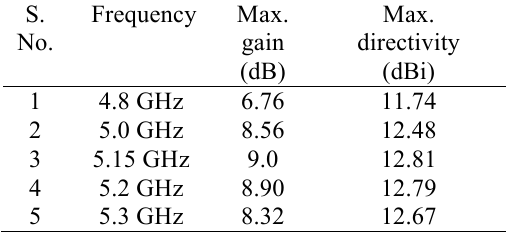
Figure 10: Radiation patterns of the array (a) in 3D at 5.15 GHz, (b) in ∅ = 0 ! plane at 5 GHz and 5.15 GHz, (c) in ∅ = 0 ! plane at 5.25 GHz and 5.35 GHz, (d) in ∅ = 90 ! plane at 5 GHz and 5.15 GHz, (e) in ∅ = 90 ! plane at 5.25 GHz and 5.35 GHz. Table 2: Max. gain and max. directivity of the